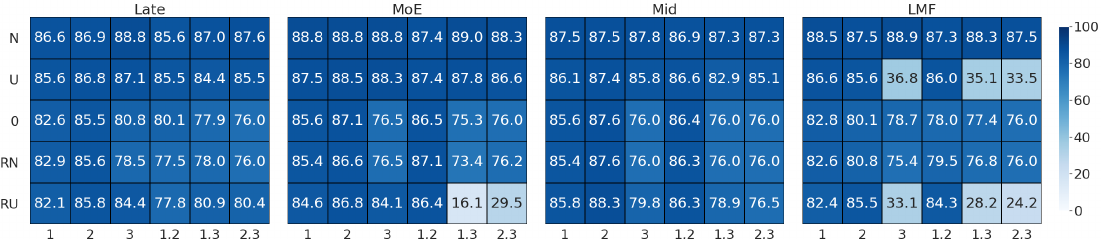
Figure 4. Results achieved by chosen models from the first stage of experiments on degraded data from the BiGS dataset. In heat-maps, there was presented a classification accuracy expressed in [%]. Rows correspond to different degradation scenarios, while columns are annotated by the indexes of affected modalities.